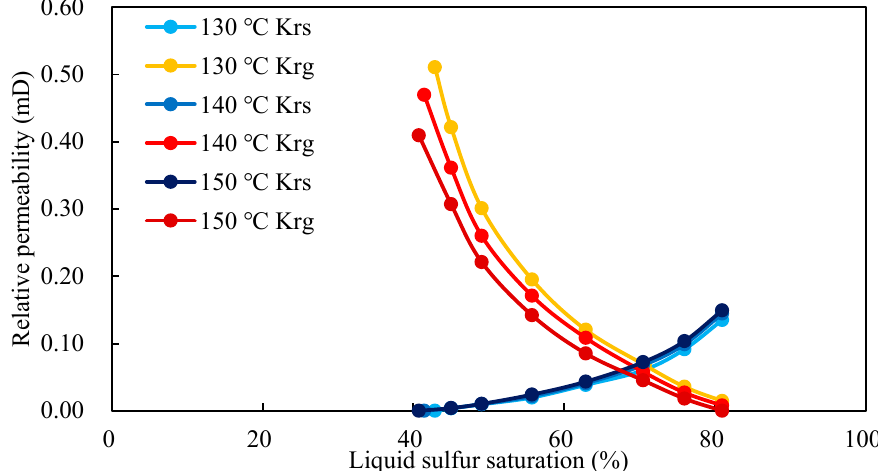
Figure 6. Gas–liquid sulfur relative permeability curves of Core 1 at different temperatures.